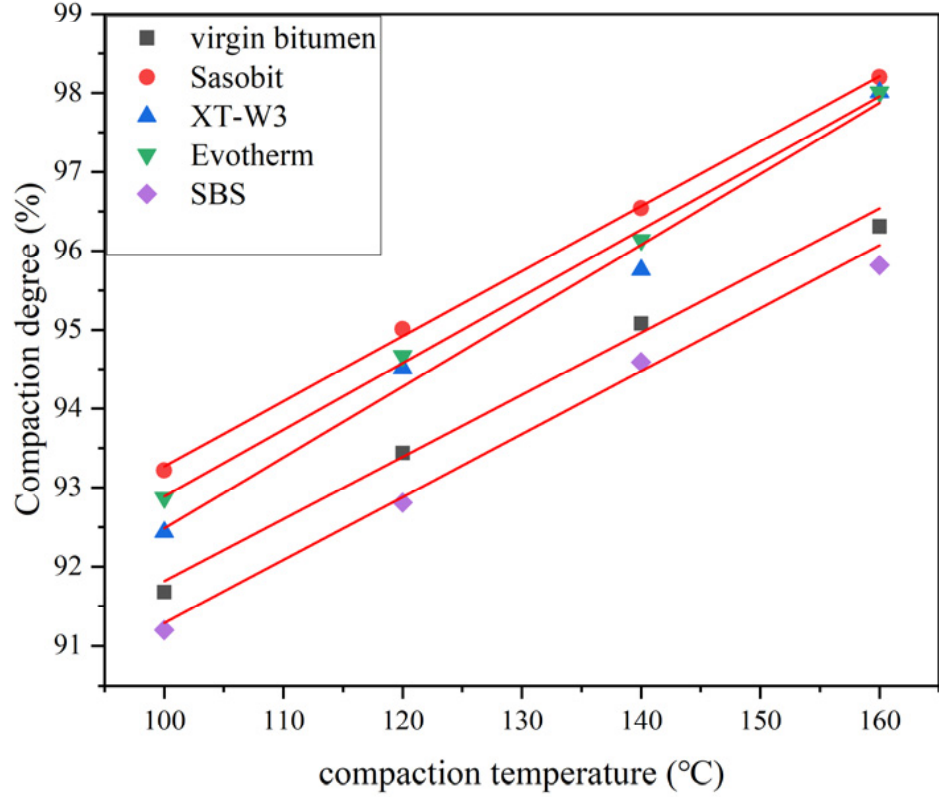
Figure 8. Relationship between compaction degree and compaction temperature. Figures 7 and 8 show that the gross bulk density and compaction of the bitumen mixture